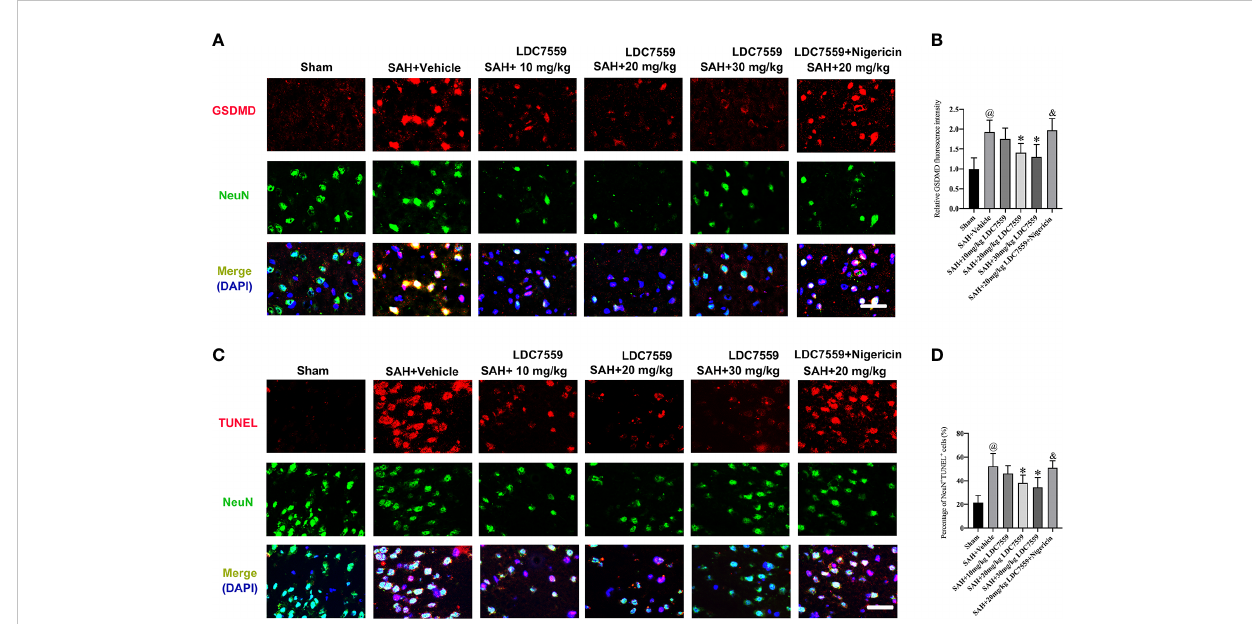
FIGURE 3 LDC7559 mitigated neuronal apoptosis and pyroptosis following SAH. Representative immuno fl uorescence microphotographs of GSDMD-positive neurons (A) in the ipsilateral hemisphere. Scale bar = 50 m m. Measurement of GSDMD-positive neurons in the ipsilateral hemisphere (B) (n = 6 per group). Representative immuno fl uorescence microphotographs of TUNEL-positive neurons (C) in the ipsilateral hemisphere. Scale bar = 50 m m. Measurement of TUNEL-positive neurons in the ipsilateral hemisphere (D) (n = 6 per group). Values are presented as the mean ± SD. @ P < 0.05 compared with sham group, * P < 0.05 compared with SAH + vehicle group, & P < 0.05 compared with SAH + 20mg/kg LDC7559